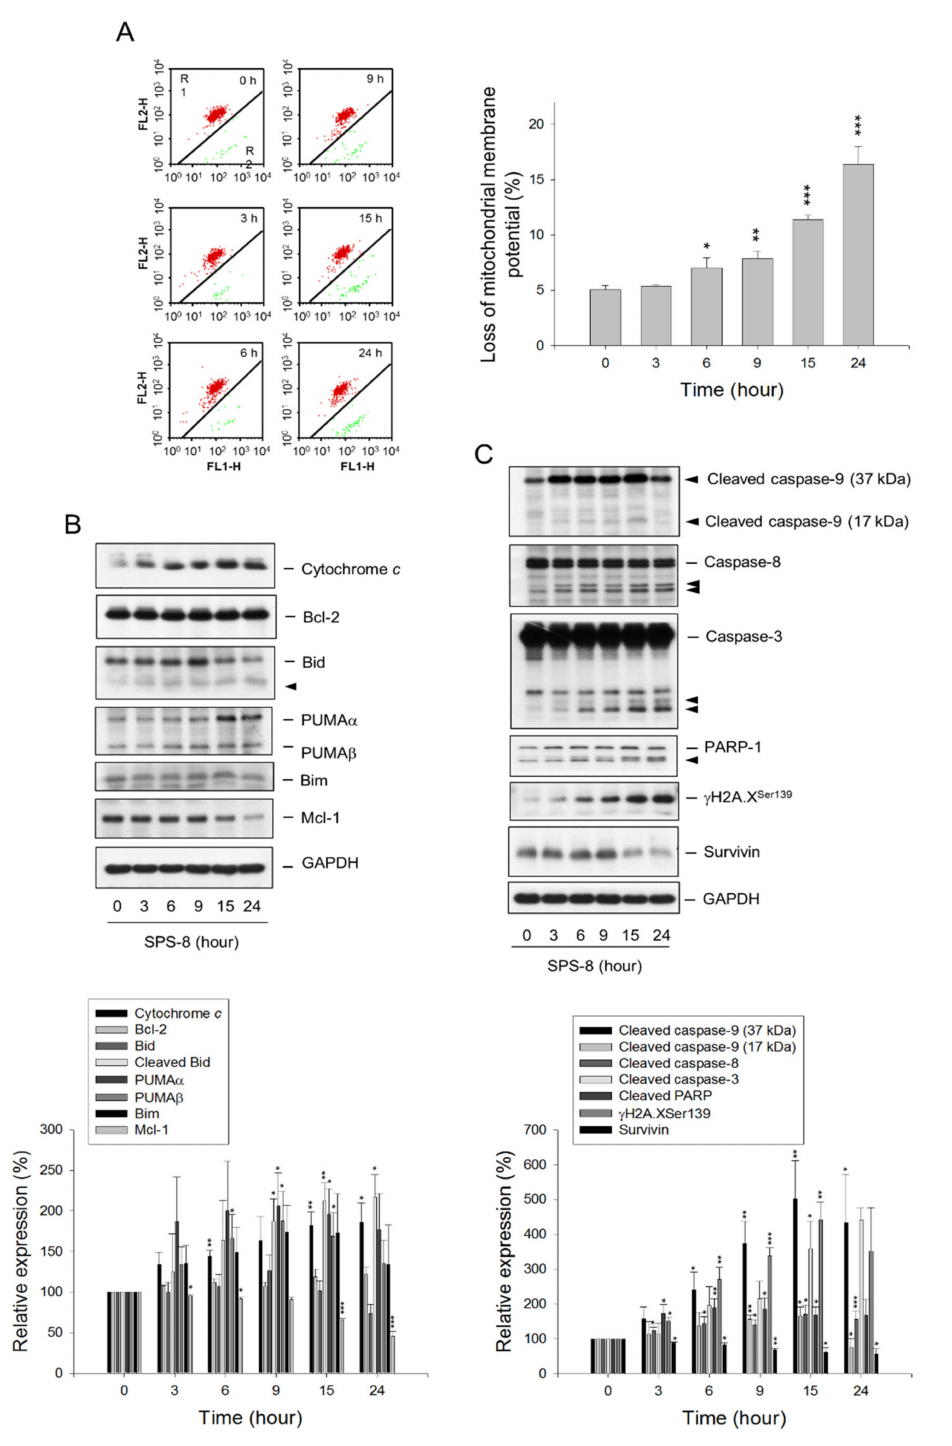
Figure 2. E ff ect of SPS8 on mitochondrial membrane potential and related protein expression. HL-60 cells were incubated in the absence or presence of SPS8 (5 µ M) for the indicated times. ( A ) The cells were incubated with JC-1 dye for the detection of mitochondrial membrane potential using a flow cytometric analysis. Data are expressed as the mean ± SEM of three independent experiments. * p < 0.05, ** p < 0.01 and *** p < 0.001 compared with the zero time control. ( B , C ) The cells were harvested for the detection of protein expression using Western blotting. The expressions were quantified using the Image Lab Software 6.0 (BIO-RAD). Data are expressed as the mean ± SEM of three to six independent experiments. * p < 0.05, ** p < 0.01 and *** p < 0.001 compared with the